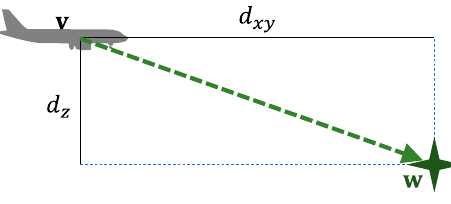
Figure 2. Vertical speed computation.